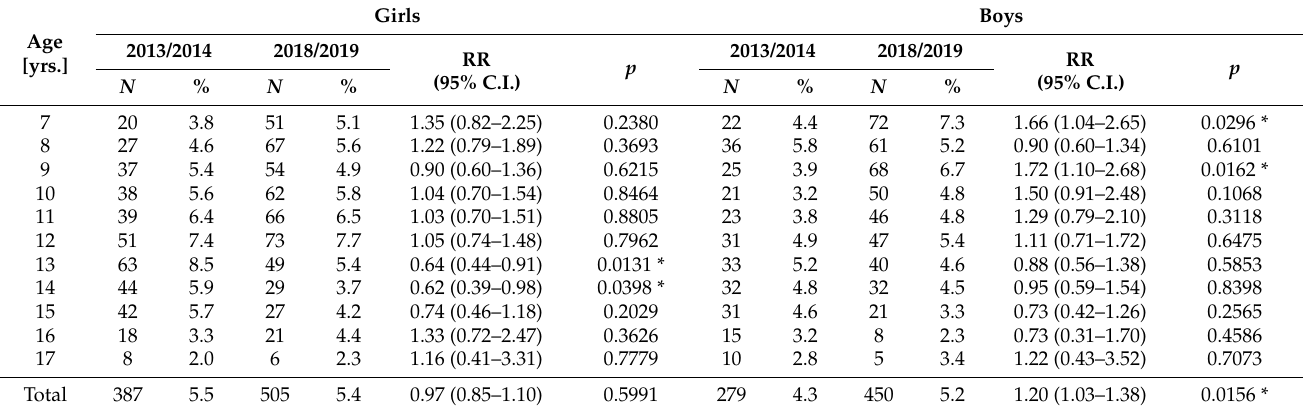
Table 4. Relative risk of underweight among Ukrainian children and adolescents in 2018/2019 vs. 2013/2014. Age [yrs.]